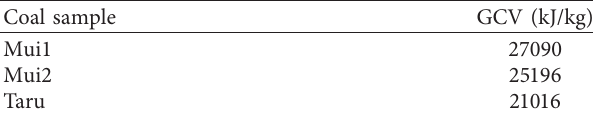
Table 3: GCV for the Mui and Taru basin